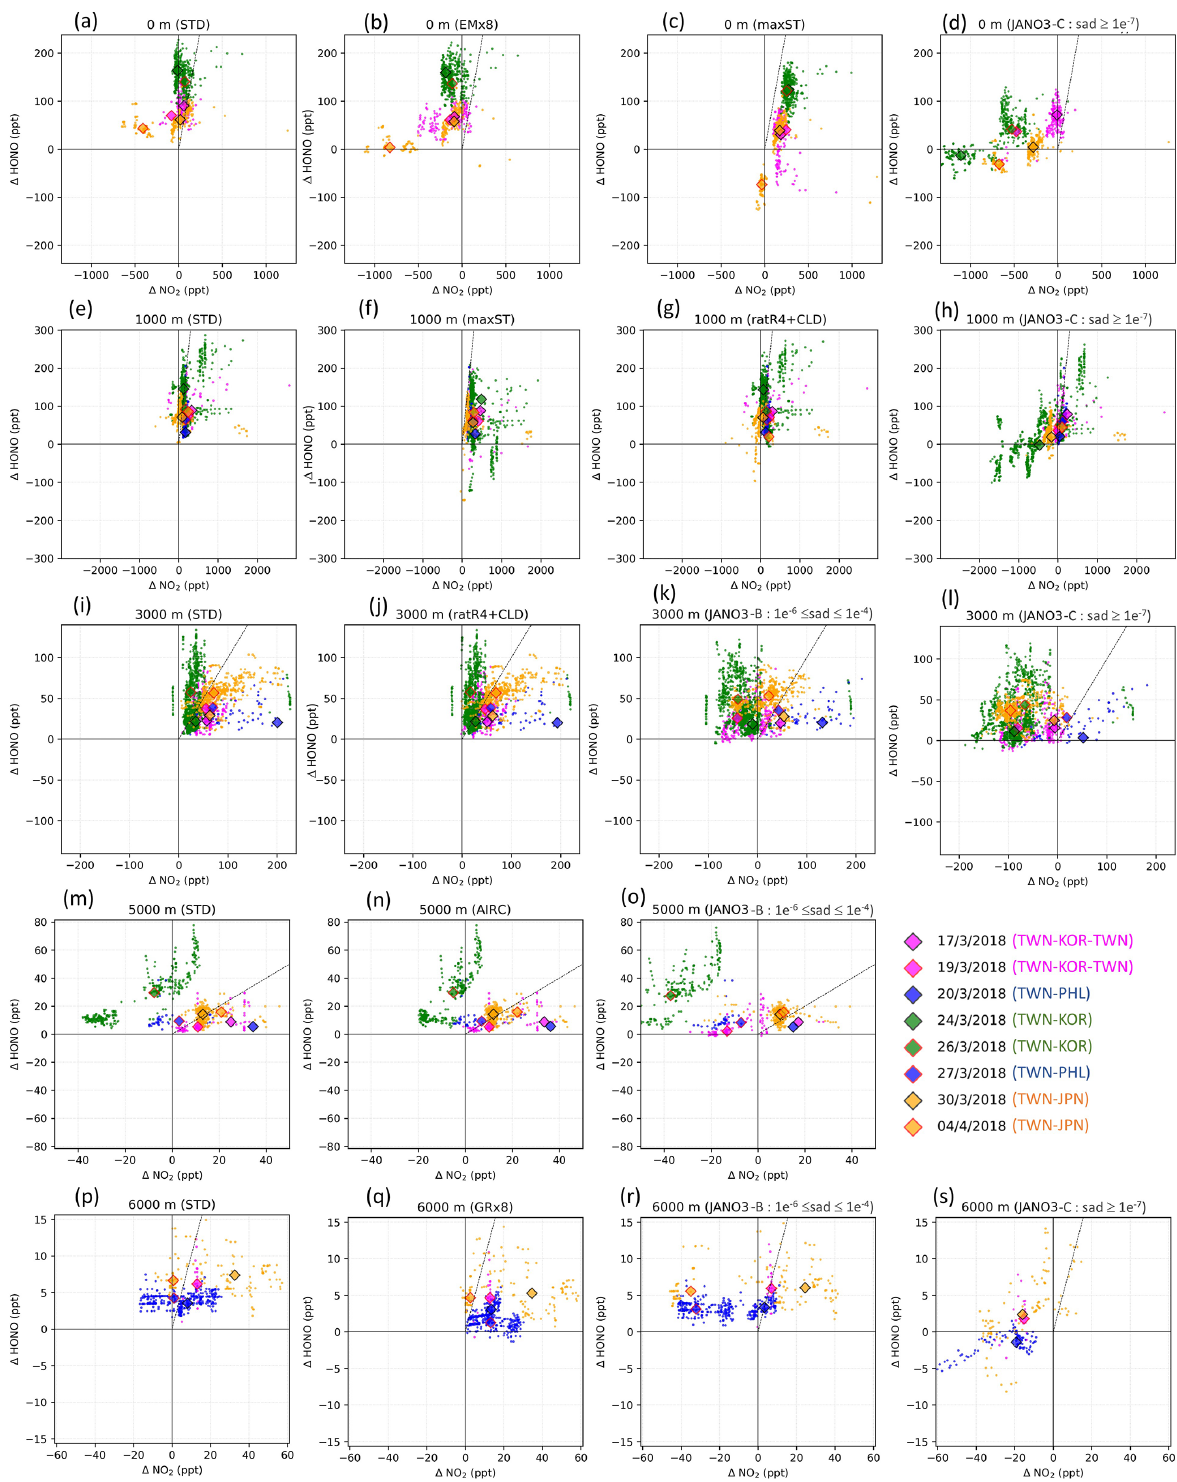
Figure 3. The model’s discrepancies from measurements for HONO ( (cid:49) HONO ) versus that for NO 2 ( (cid:49) NO column) and helpful sensitivity cases (second, third, and fourth columns) are plotted. The scale is shared for each row. The altitude range (0, 1000, 3000, 5000, 6000m ± 500m) and the sensitivity case names are shown at the top of each panel. Small points represent discrepancies distribution (observation – model). Diamonds mark the median point of each cruise distribution. Edge and fill colours indicate flight cruises (see legend). Vertical, horizontal, and diagonal lines show (cid:49) NO